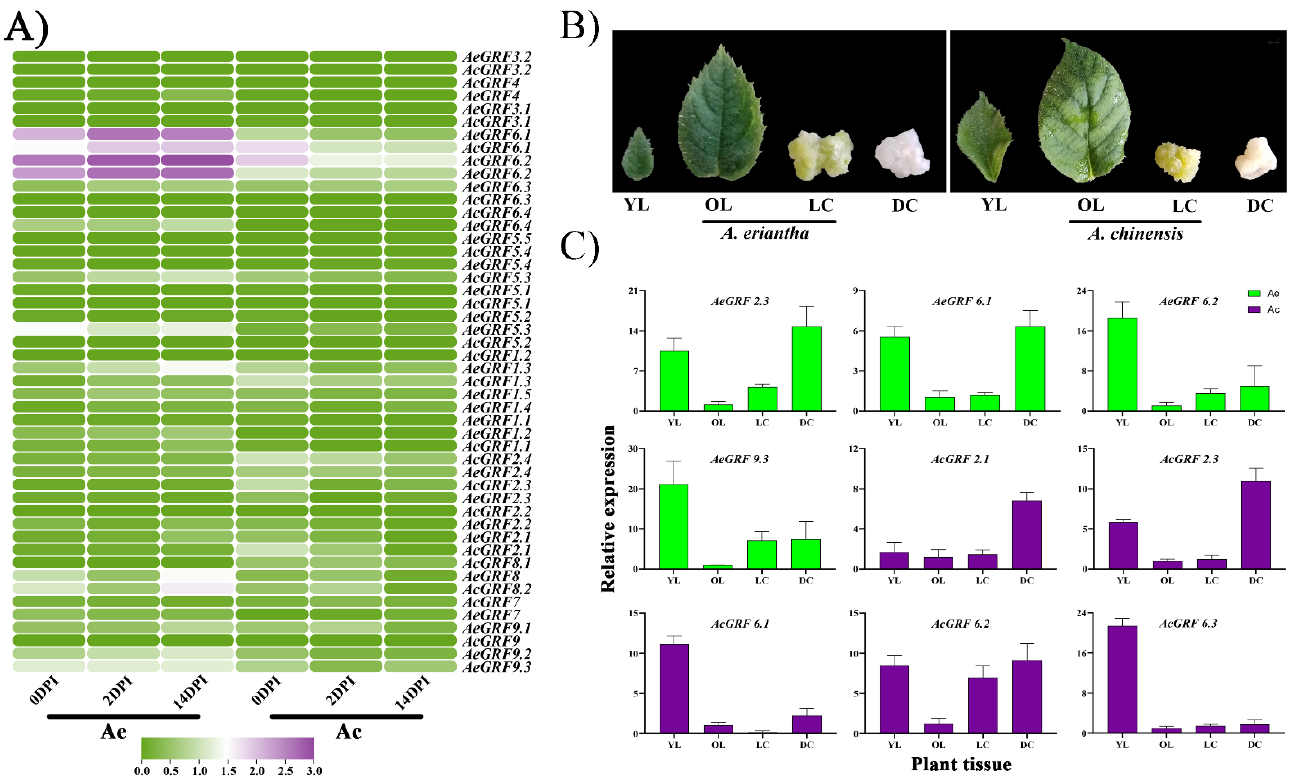
Figure 5. Expression analysis of GRFs in kiwifruit. ( A ) Heatmap for 22 AcGRFs and 26 AeGRFs under Psa. invasion in Ac and Ae. ( B ) Phenotype for different kiwifruit tissues used for RT-qPCR analysis. ( C ) RT-qPCR analysis for nine highly expressed genes from four different RNA-seq datasets. The YL stands for young leaves, OL stands for old leaves, LC stands for callus under light treatment, DC stands for callus under dark treatment, and DPI stands for days post-inoculation of Psa.